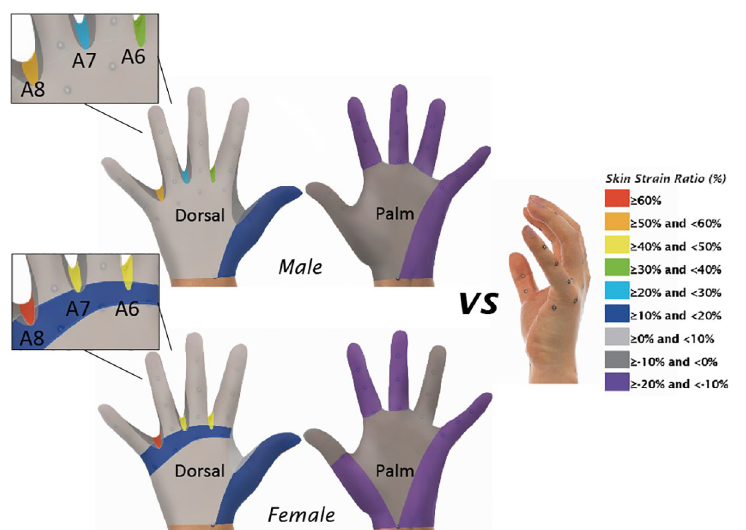
Fig 6. Skin strain ratio from gripping to splayed